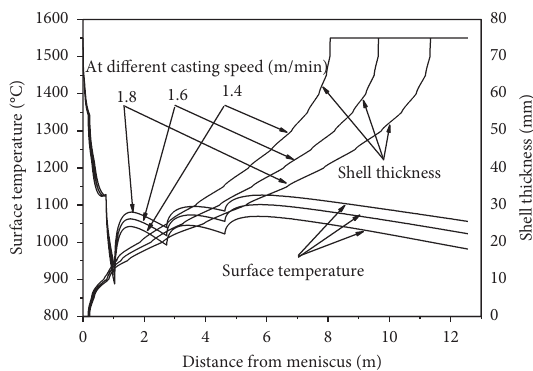
Figure 3: Temperature profile and solid shell